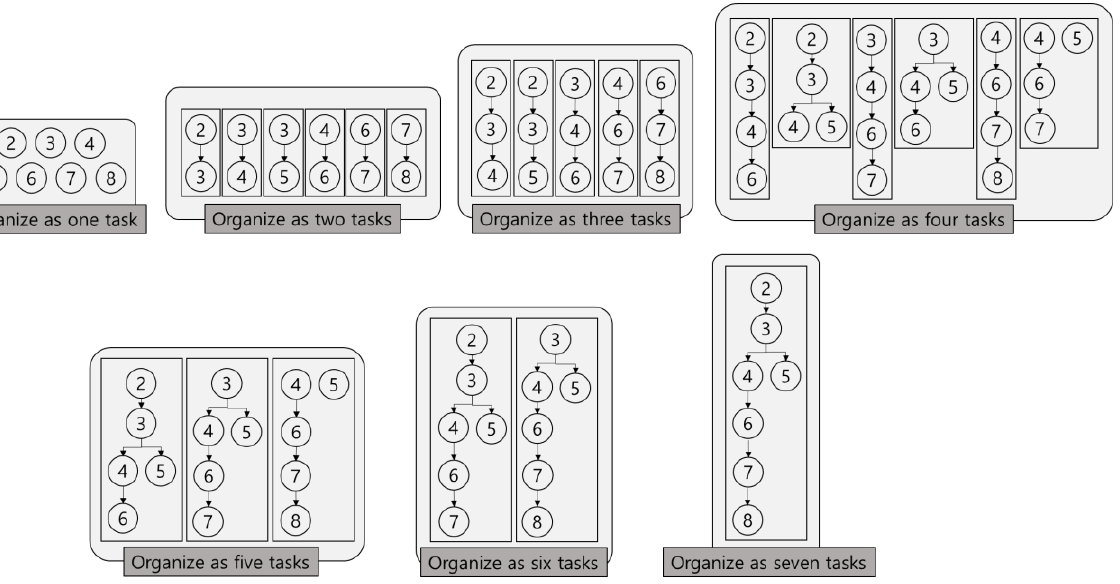
Figure 5. Offloading group of Task relevance.